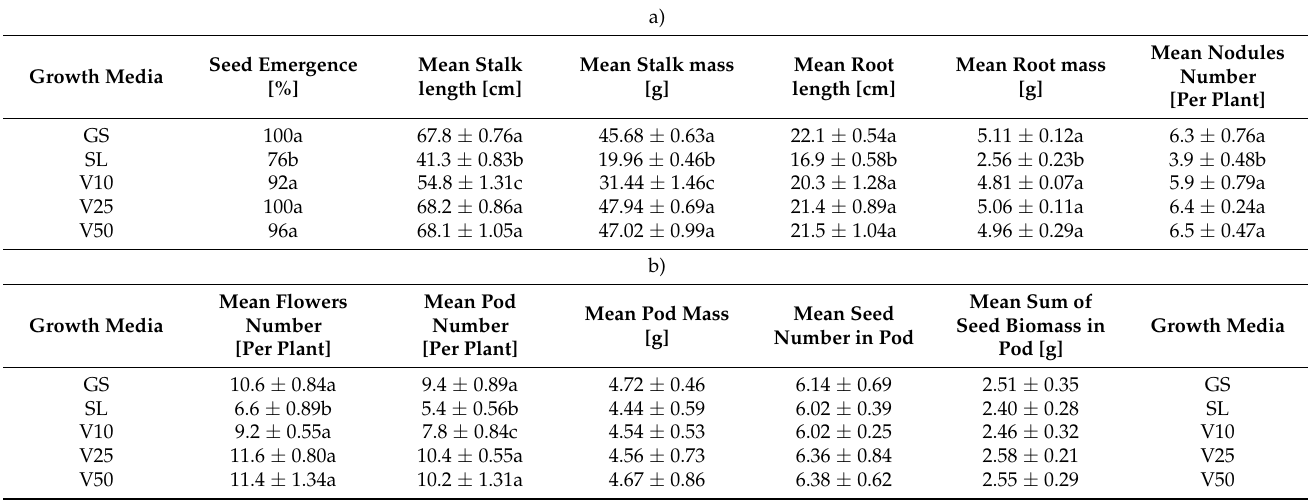
Table 2. Selected plant features for the given treatment growth media (as in Table 1) (mean ± standard deviation based on five